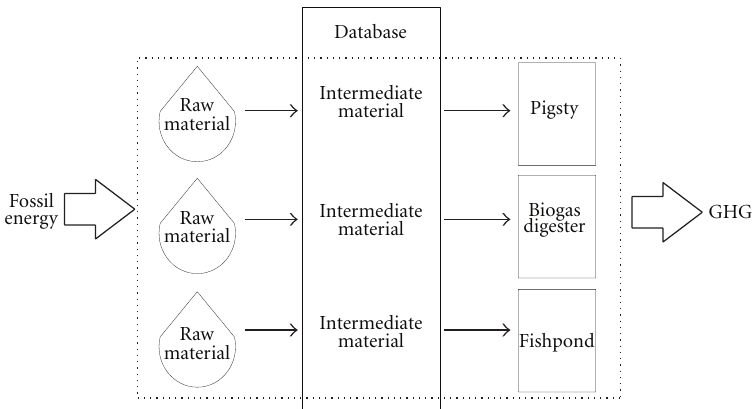
Figure 1: The boundary of the “pig-biogas-fish” system.